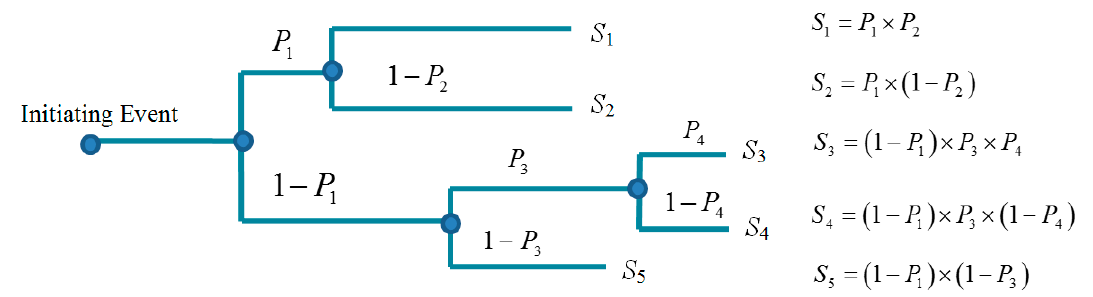
Figure 2. The algorithm flow chart of the fuzzy fault tree analysis (FFTA). FTD: fault tree diagram; FMECA: failure mode effects and criticality analysis.